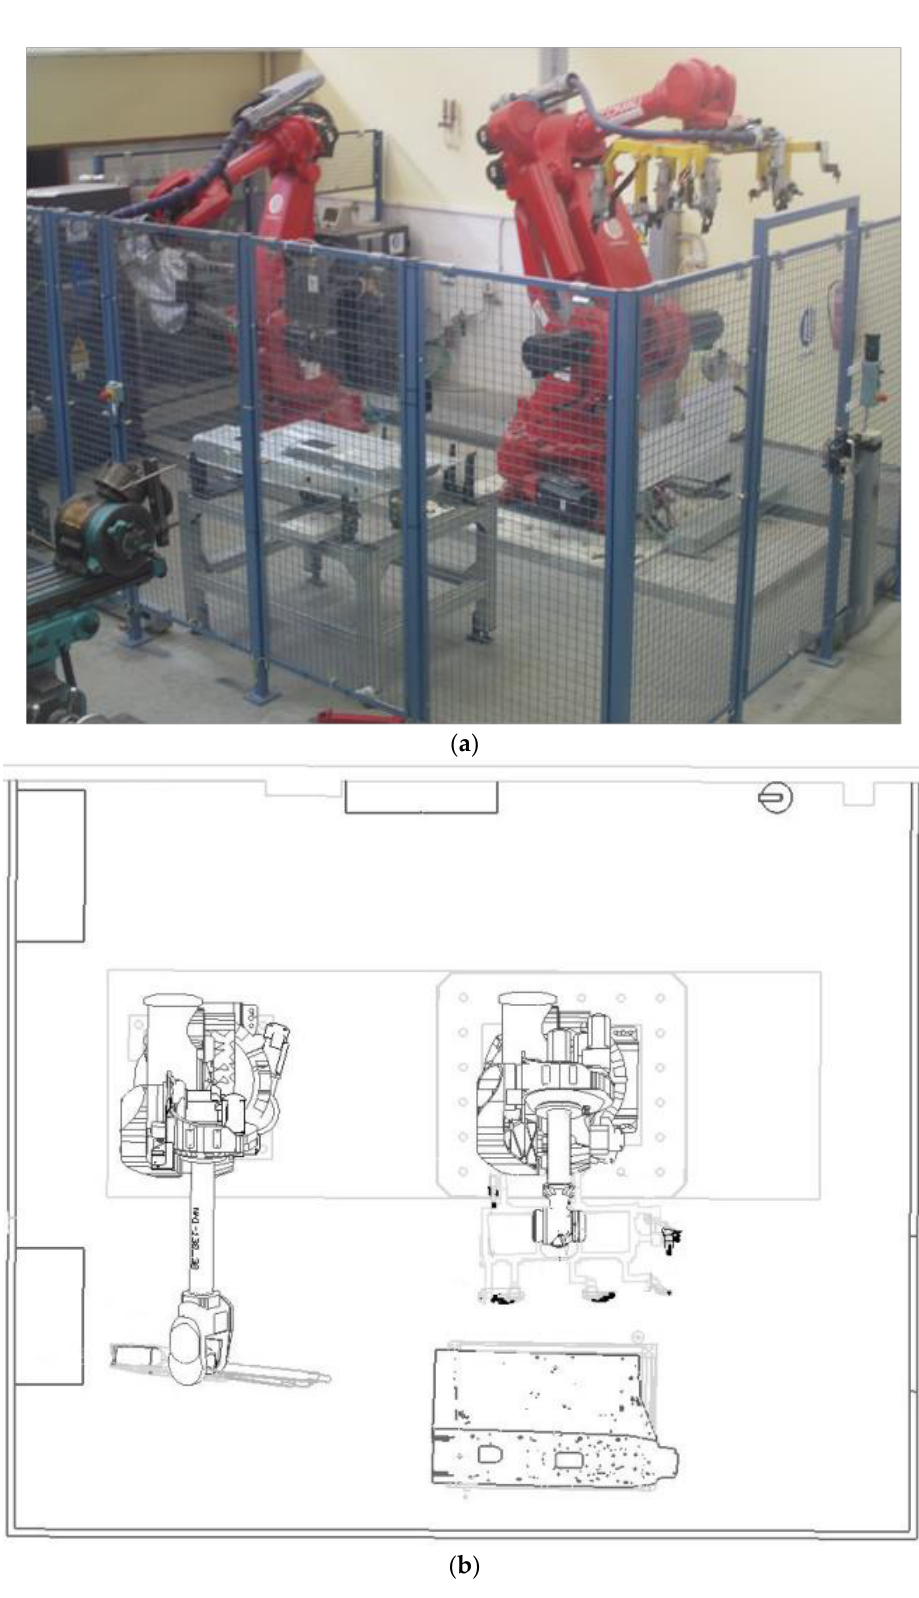
Figure 1. Robotic assembly cell ( a ) photo and ( b ) top-view layout.